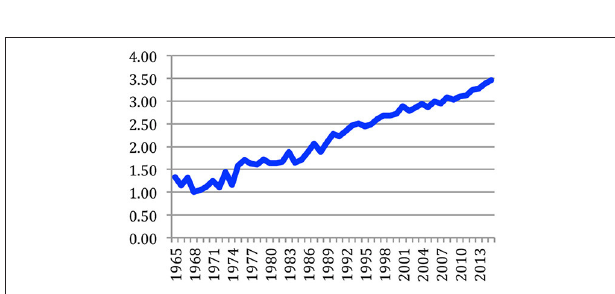
FIGURE 16 | Average number of authors per paper.